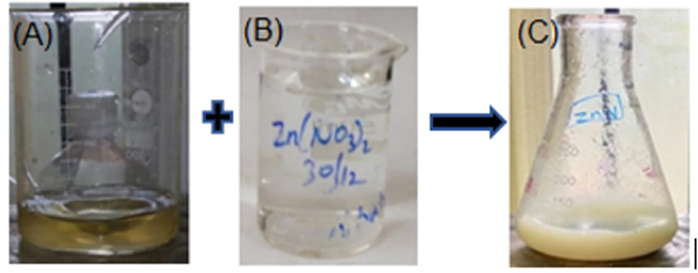
Figure 1. Synthesis of ZnONP. ( A ) C. cuspidatus leaf extract, ( B ) zinc nitrate, ( C ) ZnONP.